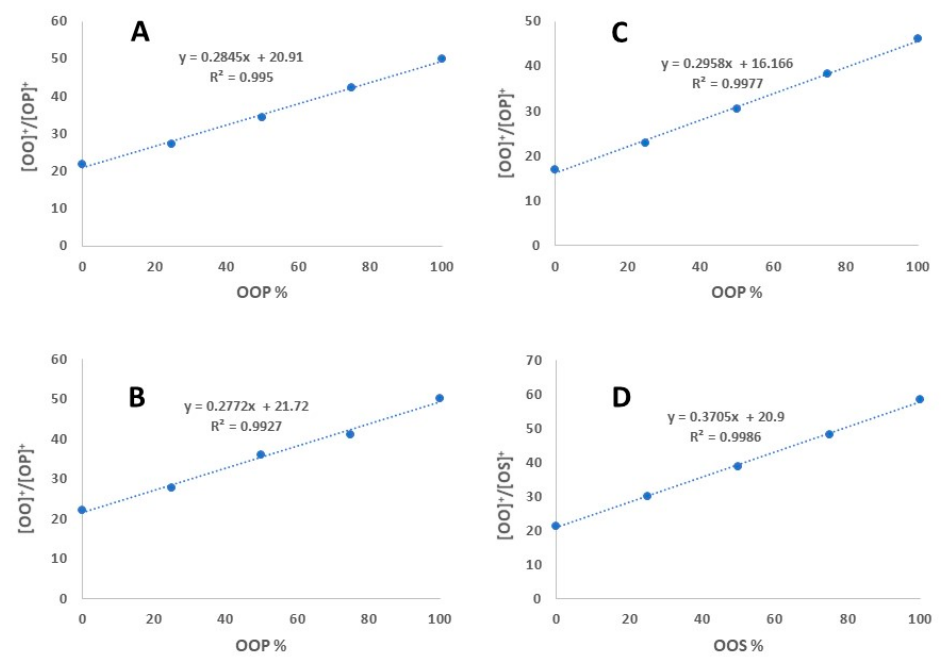
Figure 2. Calibration curves (fragment ion ratio vs. regioisomer %) for OPO/OOP and OSO/OOS pairs. ( A ) linear regression with 0.01 mg/mL standards (OPO/OOP) and 35 eV collision energy; ( B ) linear regression with 0.001 mg/mL standards (OPO/OOP) and 35 eV collision energy; ( C ) linear regression with 0.01 mg/mL standards (OPO/OOP) and 25 eV collision energy; ( D ) linear regression with 0.01 mg/mL standards (OSO/OOS) and 35 eV.